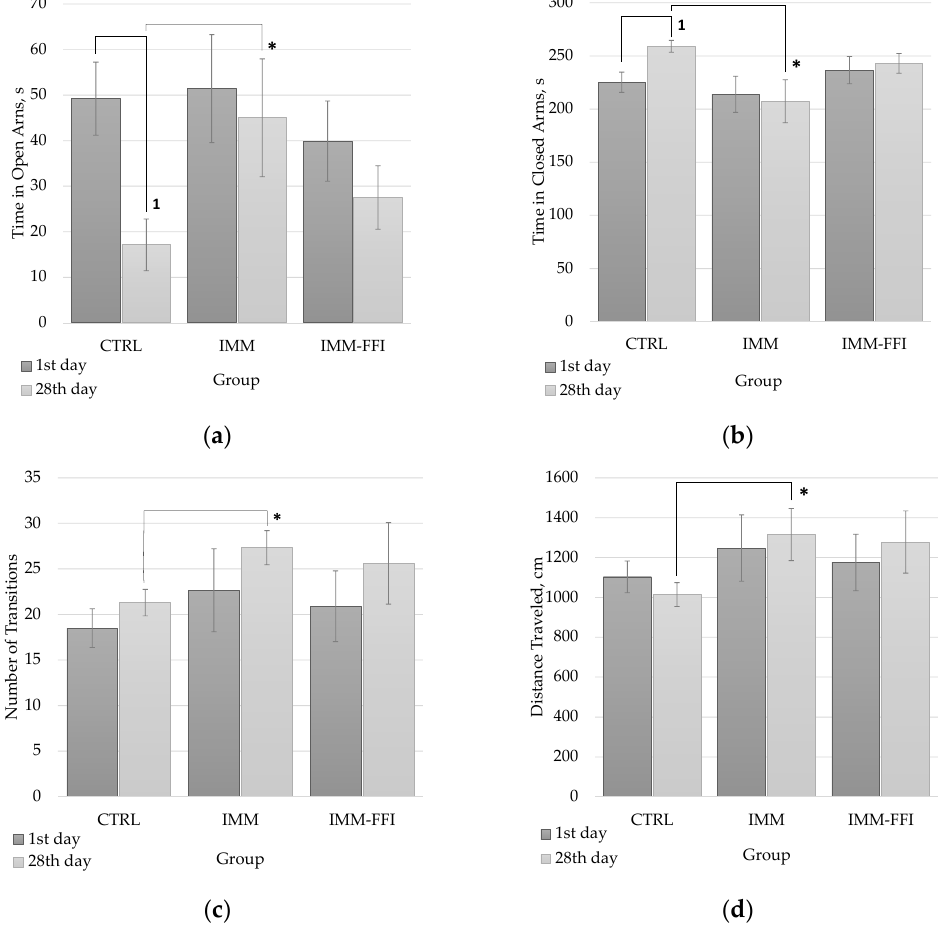
Figure 2. EPM testing results: ( a ) time in open arms, s; ( b ) time in closed arms, s; ( c ) a number of transitions between maze arms; ( d ) distance traveled in the maze, cm. First test before feeding by experimental rations. Second test on the 28th day of the experiment. 1—differences are significant ( p < 0.05) compared with 1st test. * —differences are significant compared with the CTRL group, p <